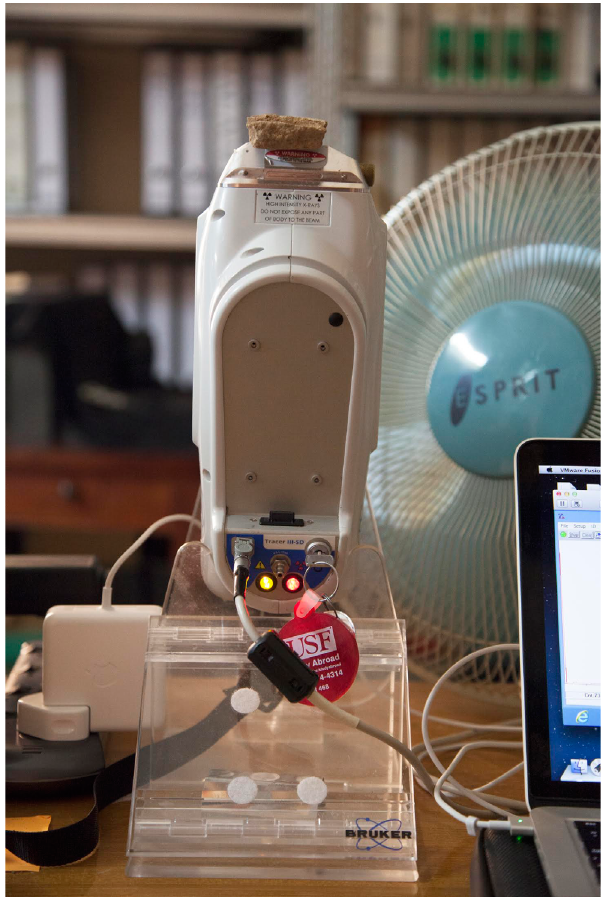
Figure 3. The Bruker Tracer III-SD portable X-ray fluorescence spectrometer (pXRF) analyzing a ceramic sherd at the National Museum of Archaeology, Valletta, Malta (photograph by Fred Pirone).